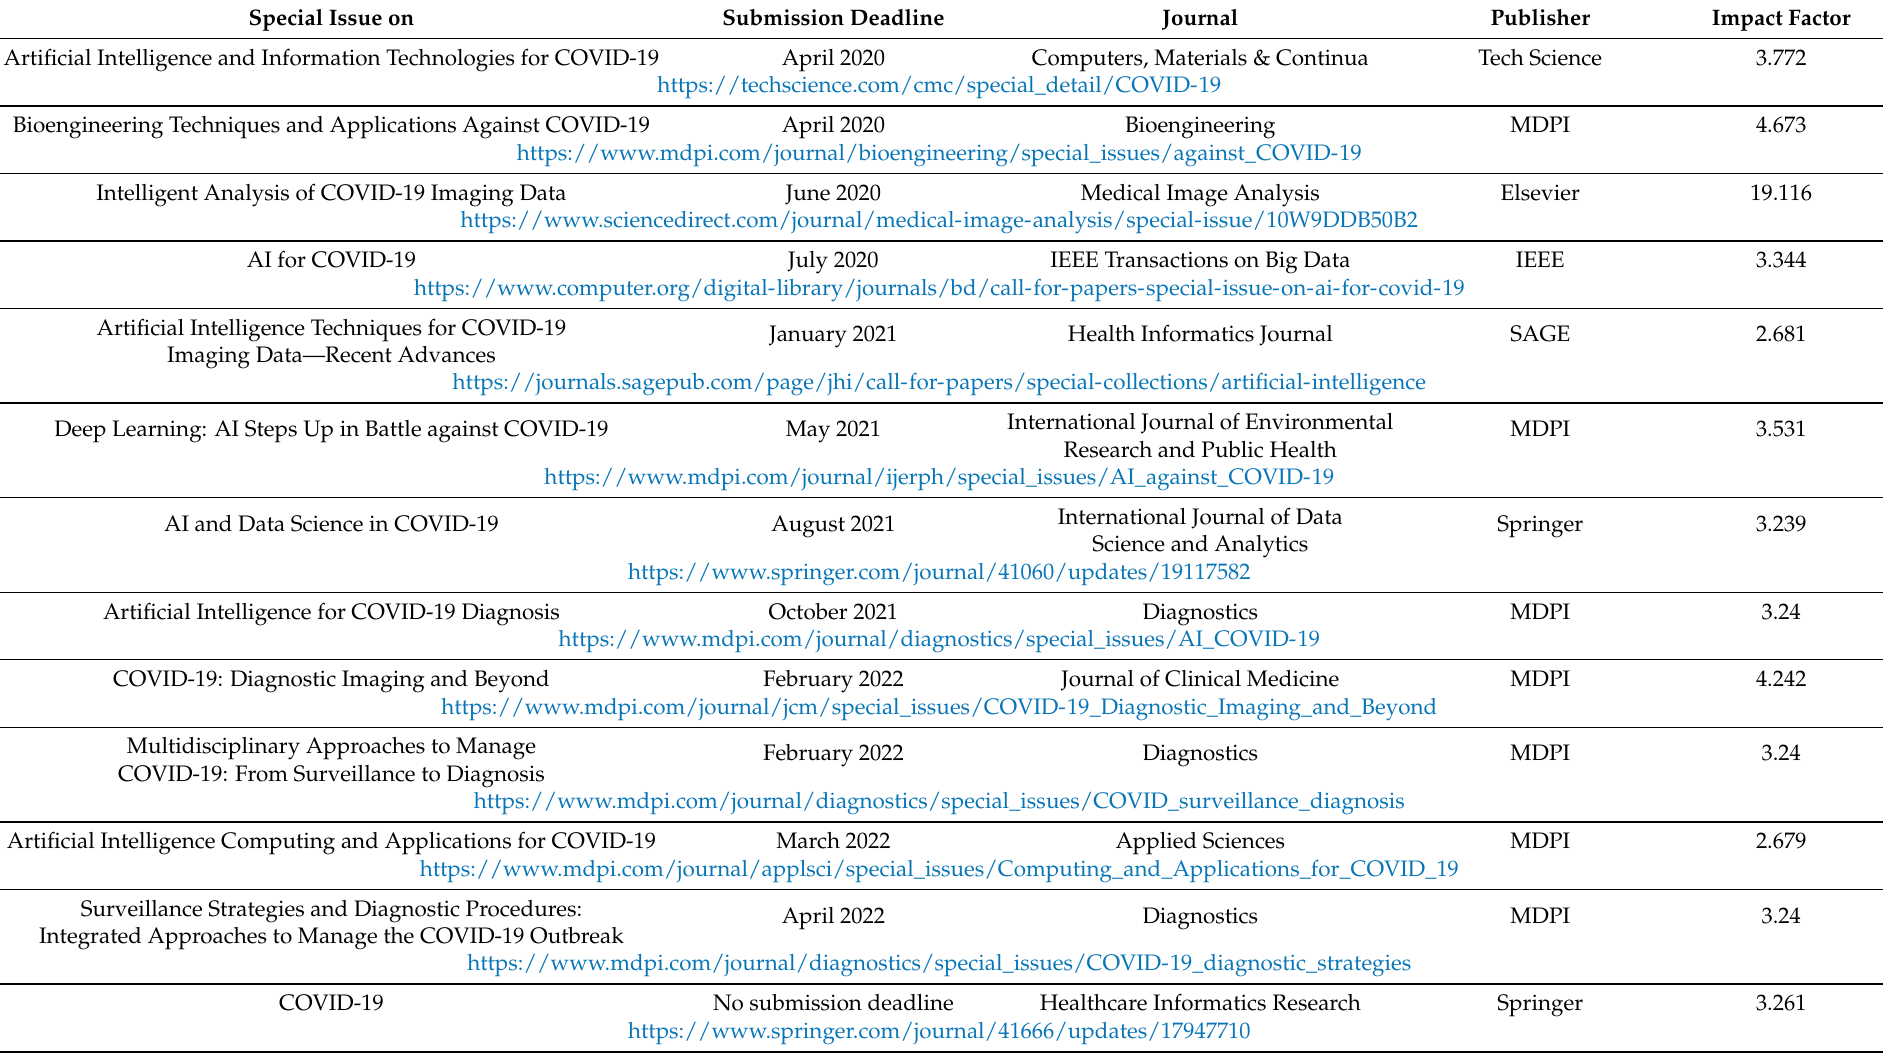
Table 1. The special issues that have been held by various journals during 2020–2022. All links are accessed on 5 March